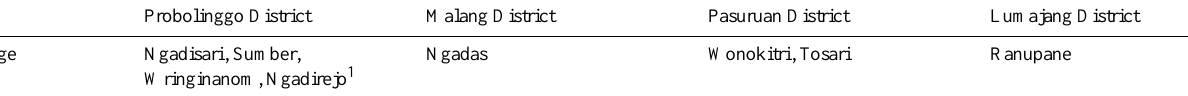
Table 2. Survey method at village around Bromo